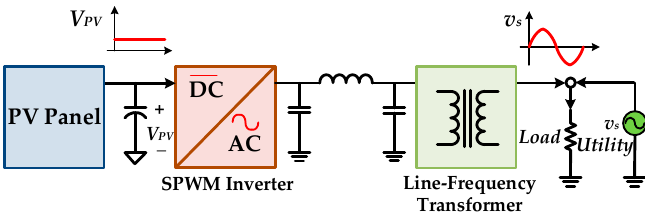
Figure 1. PV grid-connection systems with a line-frequency transformer.